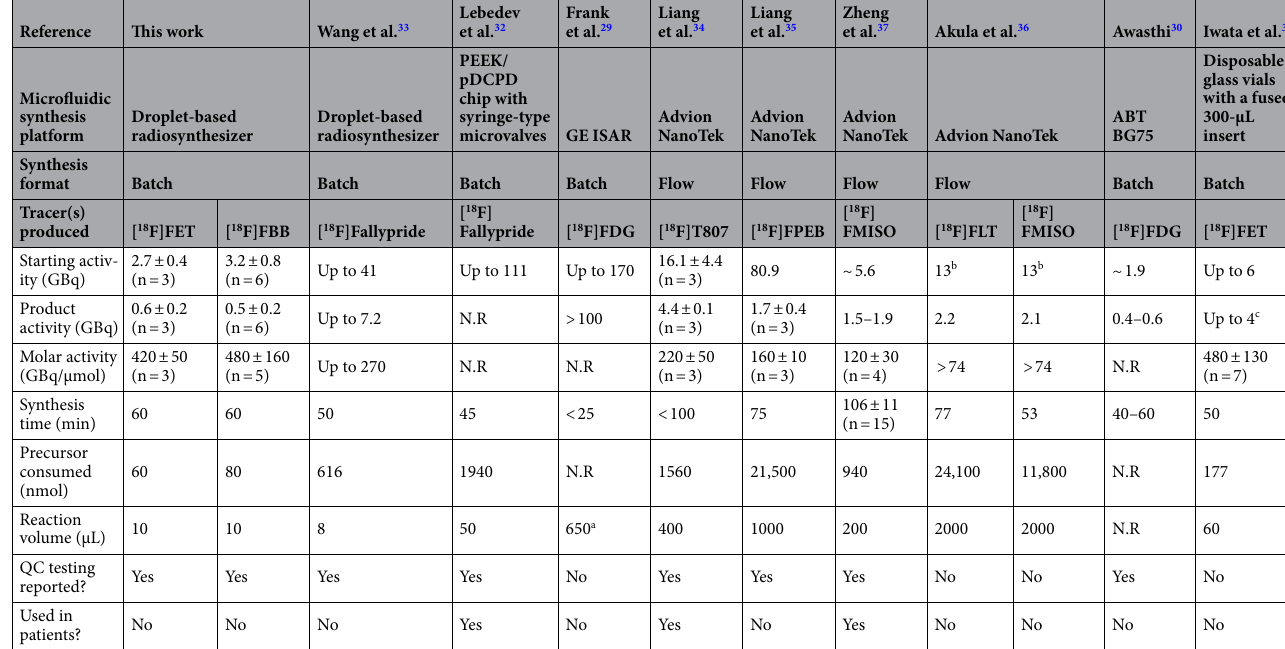
Table 1. Literature reports of microfluidic production of 18 F-labeled radiopharmaceuticals with sufficient quantities for human PET. N.R. not reported. a Precise reaction volume was not reported, but the total reactor size was 650 µL. b Total activity used for [ 18 F]FLT and [ 18 F]FMISO sequential syntheses combined is reported, approximately half used in each synthesis. c Estimated from reported crude yield value for 6 GBq starting activity and assuming 50 min synthesis